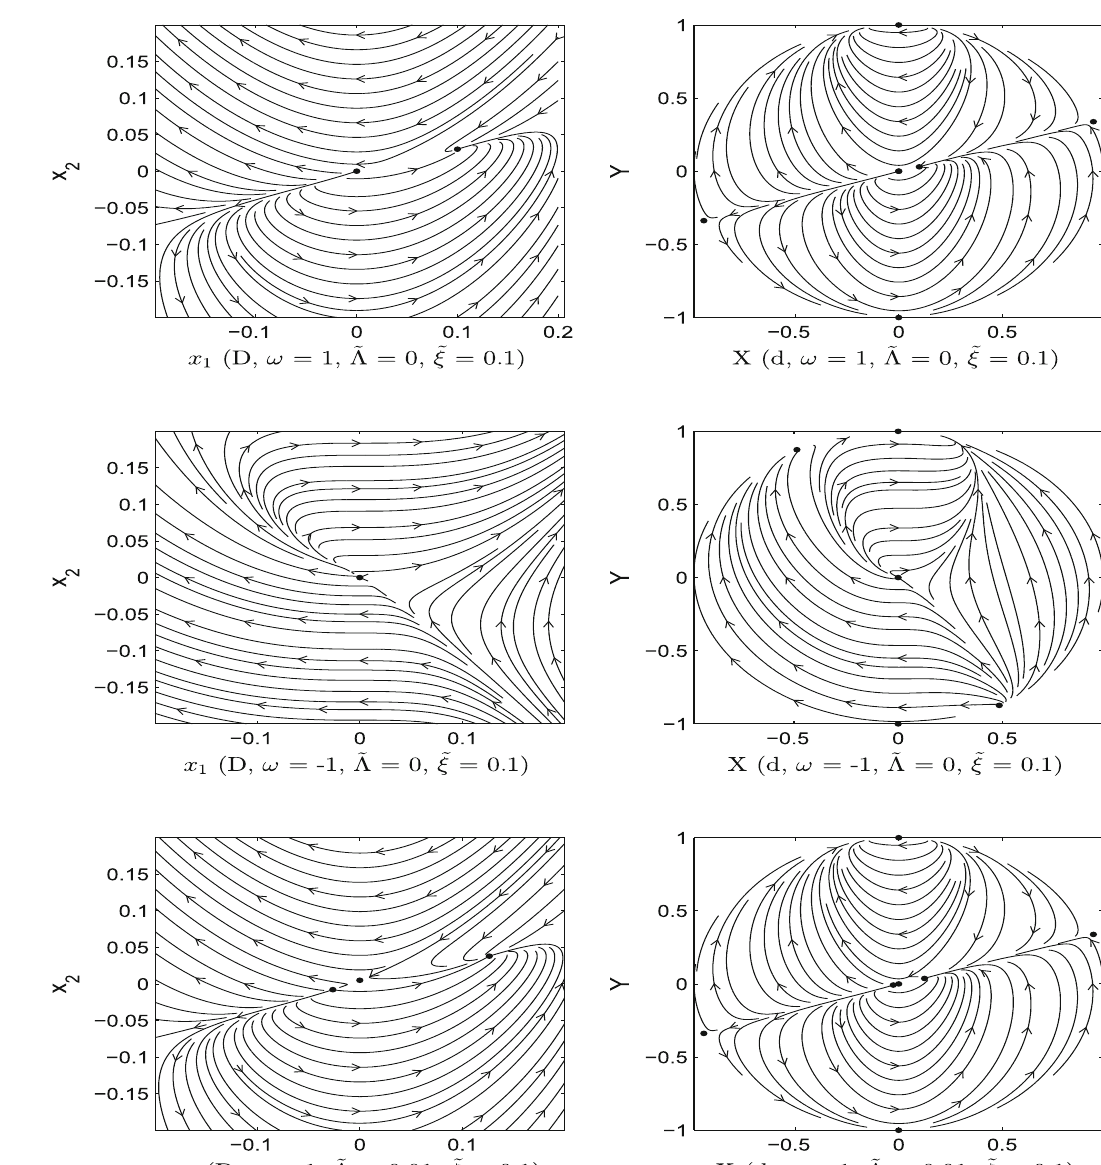
Fig. 14 Uncompact (left panel) and compact (right panel) phase por- x 2 respectively denote the dimensionless ˜ H and ˜ ρ as defined in Eq. (7). X and Y arethecoordinatesonthePoincarésphereasdefinedinEq.(47). traits when viscosity is included, ˜ ξ = 0 . 1. Representative cases are (cid:11) (cid:12) (cid:11) (cid:12) (cid:11) (cid:12) The dotted circles represent fixed points ω = 1 , ˜ (cid:4) = 0 ω = − 1 , ˜ (cid:4) = 0 ω = 1 , ˜ (cid:4) = 0 . 01 , and . x 1 and